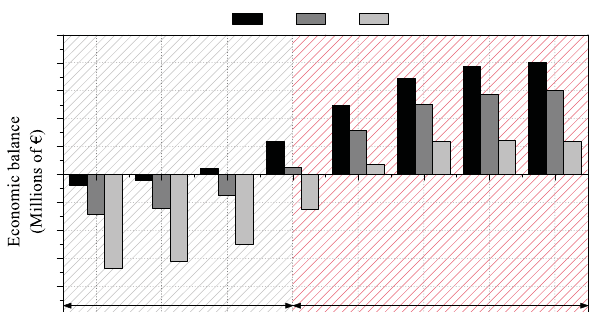
Table 7. Global savings obtained for each retrofitting package rP retrofitting package